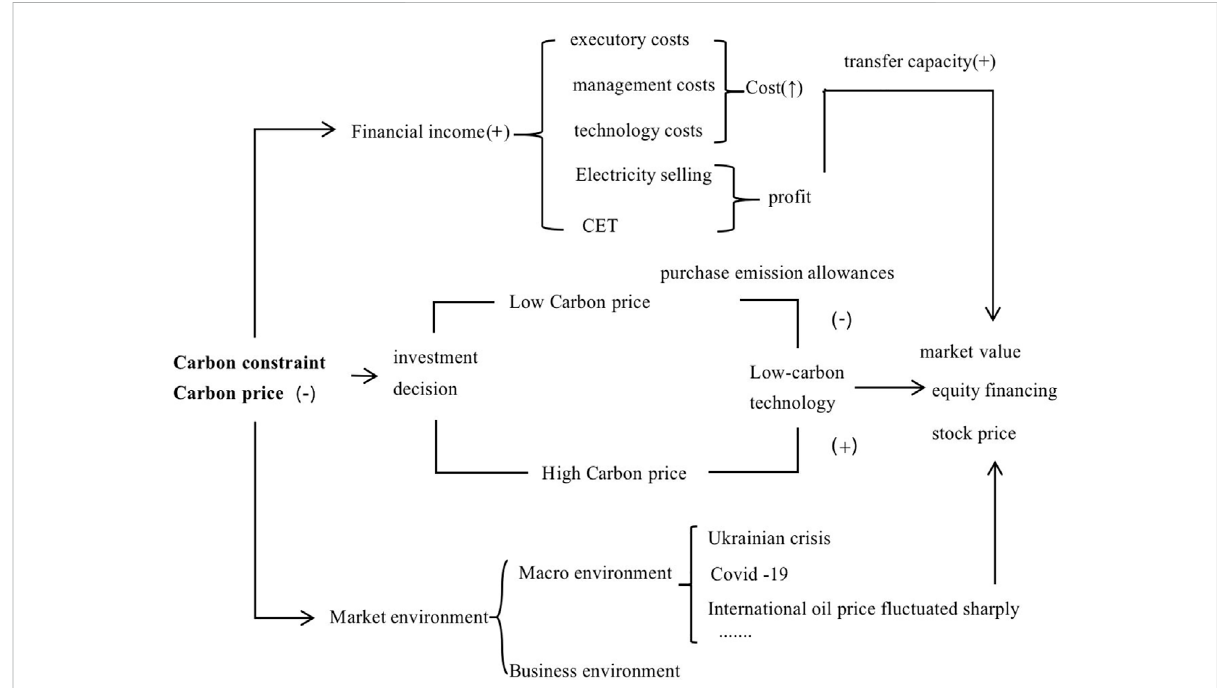
FIGURE 2 Impact mechanism of carbon constraints on equity fi nancing of power enterprises.